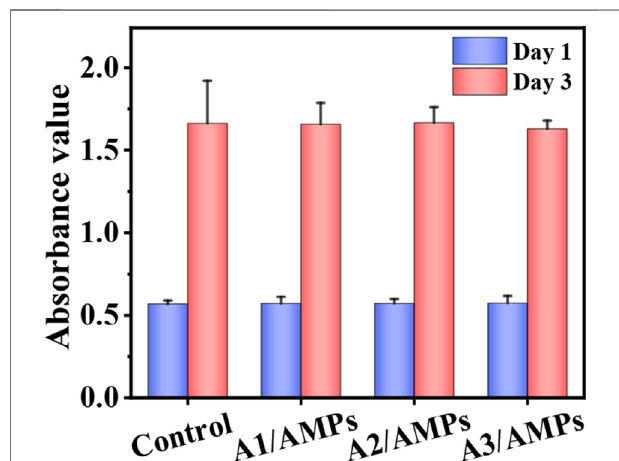
FIGURE 5 | The biocompatibility of the extracts from different HA/AMPs MSs when cultured with mBMSCs, n (cid:2) 5.